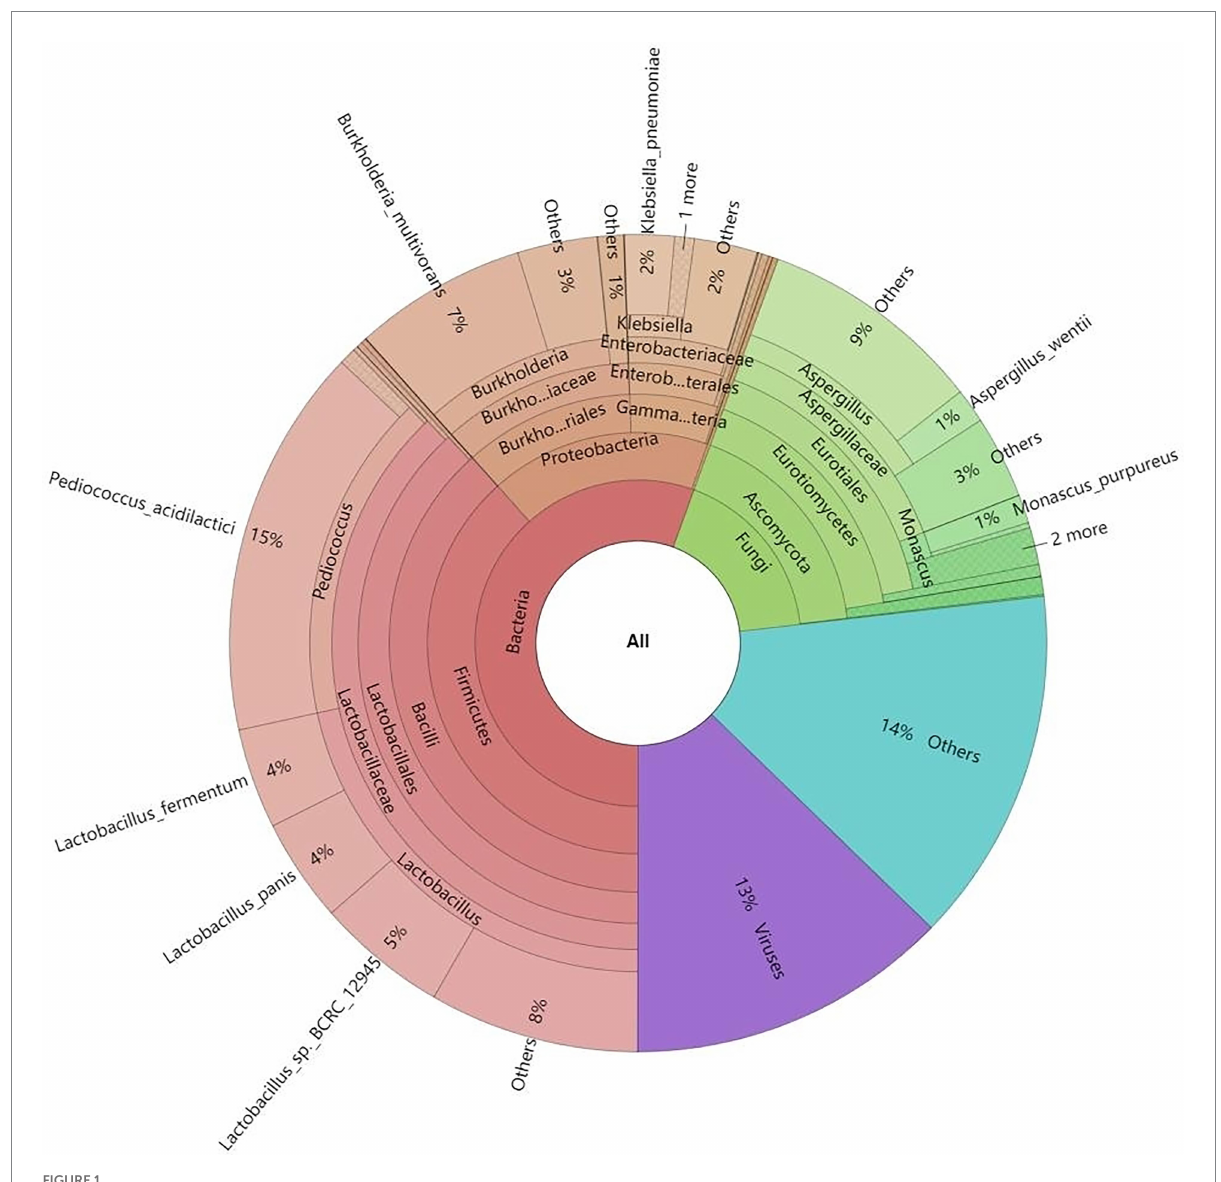
FIGURE 1 Krona diagram of the microbial community of red vinasse